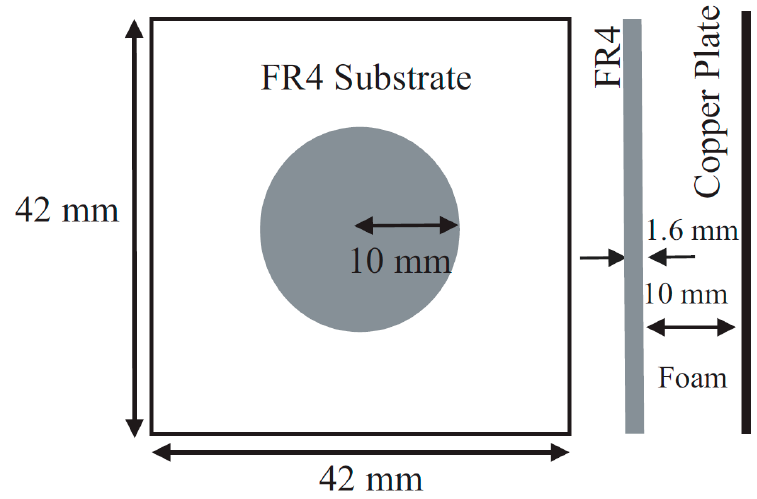
Figure 1. Top view and side view of the circular patch-type unit cell.